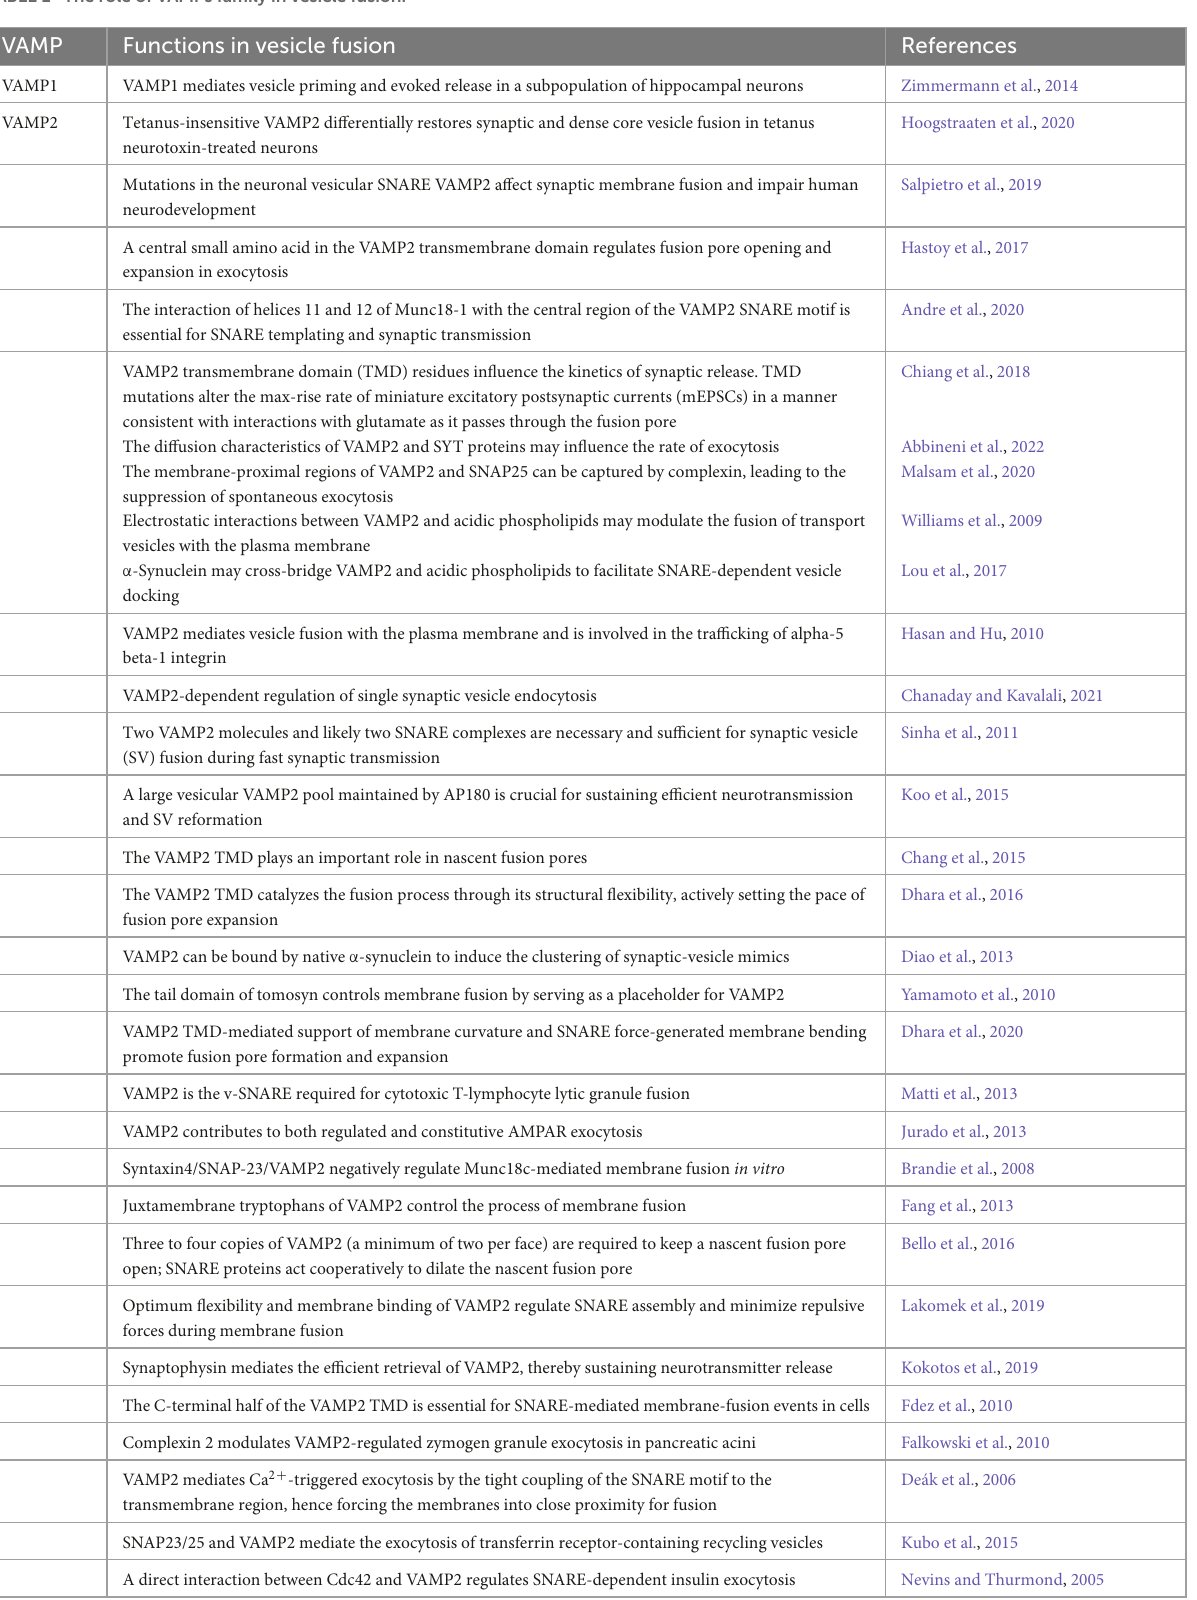
TABLE 1 The role of VAMPs family in vesicle